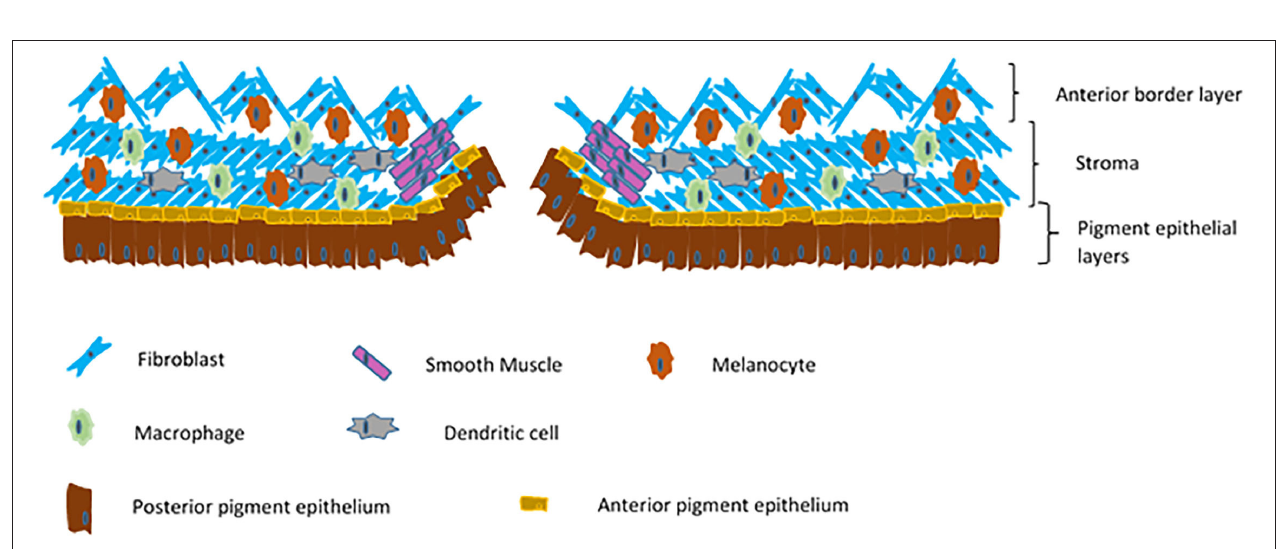
FIGURE 2 | Schematic of a cross section of an iris.